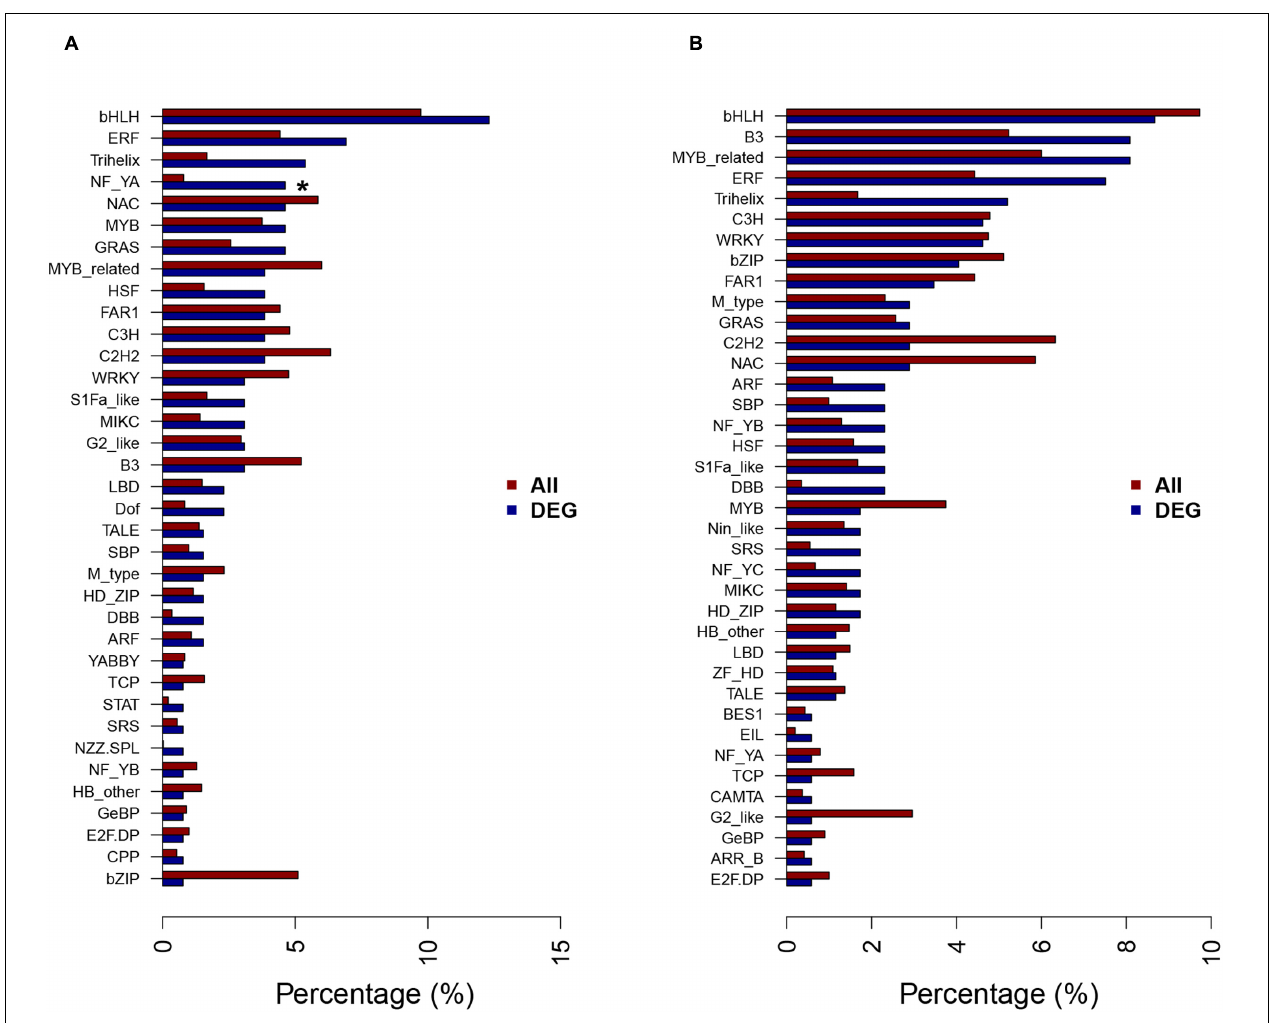
FIGURE 6 | Transcription factor families of the DEGs at 12 h (A) and 24 h (B) of NaHCO 3 treatment. A total of 130 and 173 transcription factors (TFs) were differentially expressed at 12 and 24 h after 90 mM NaHCO 3 (pH 8.5) stress, respectively, and the percentages of TF families in DEGs and all genes in soybean genome were shown as blue bars and red bars, respectively. ∗ Significantly enriched TF family identified by hypergeometric Fisher exact test ( P < 0.01) and Benjamini and Hochberg method (FDR <